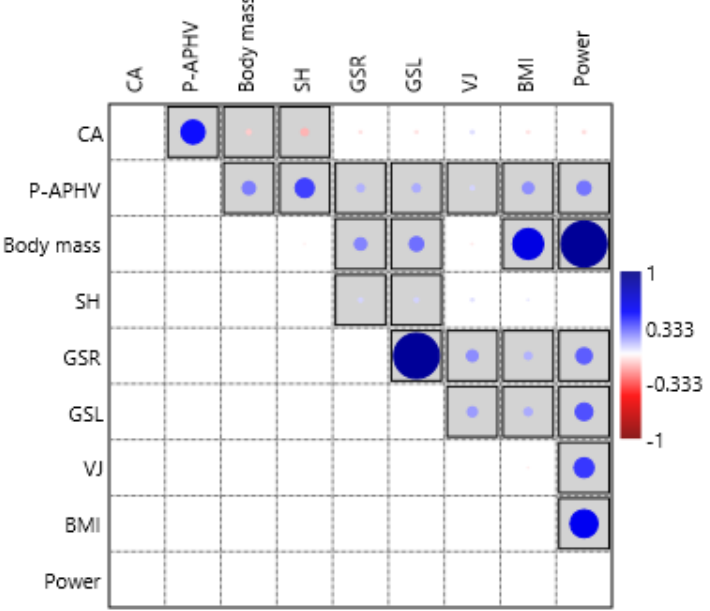
Figure 1. Correlation plot between power and other variables (correlations with significant p values are shown in the box).